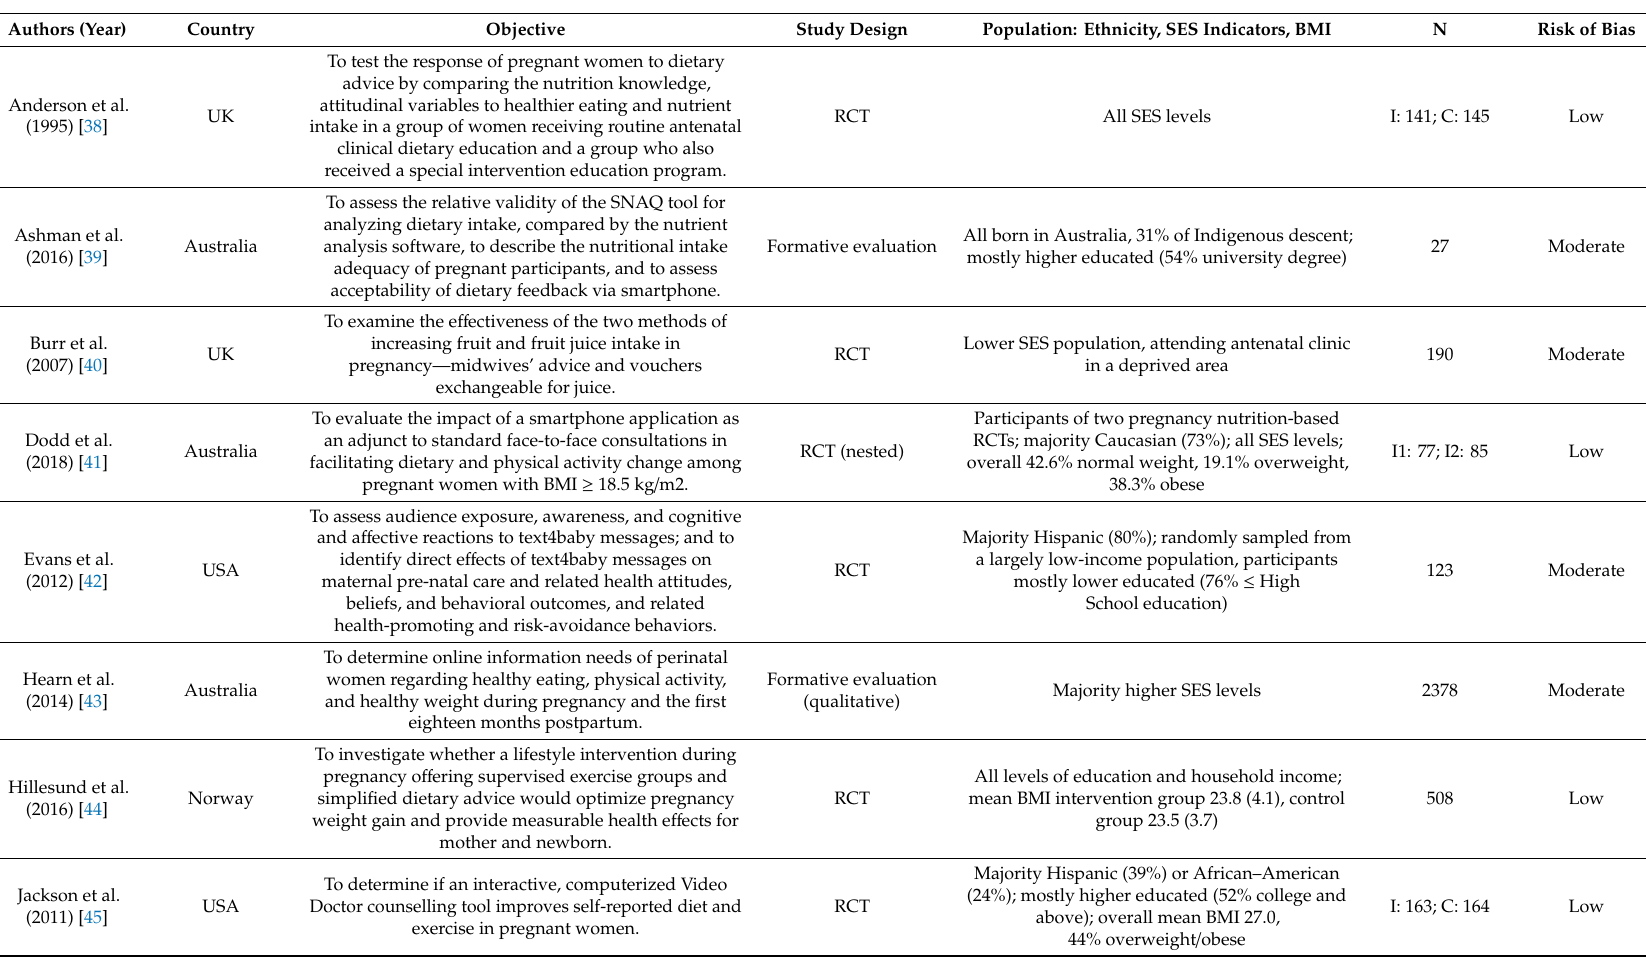
Table 2. Overview of bibliographic information, objectives, study design and population, and risk of bias in the included